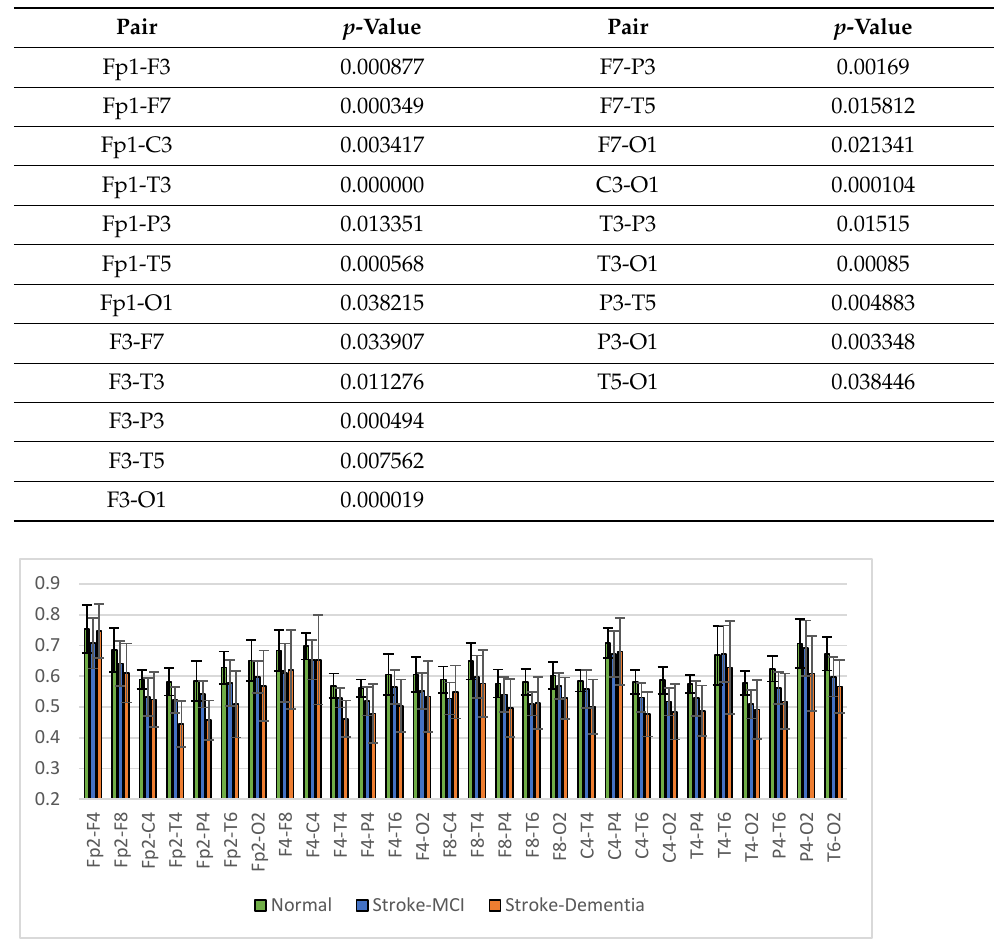
Figure 15. Right intrahemispheric coherence value of each electrode pair. Table 6. The right intrahemispheric coherence value resulted in p < 0.05. The average measurement results show that the coherence of the post-stroke patient group with cognitive impairment is generally lower than the normal group. This condition occurs in almost all interhemispheric and intrahemispheric electrode